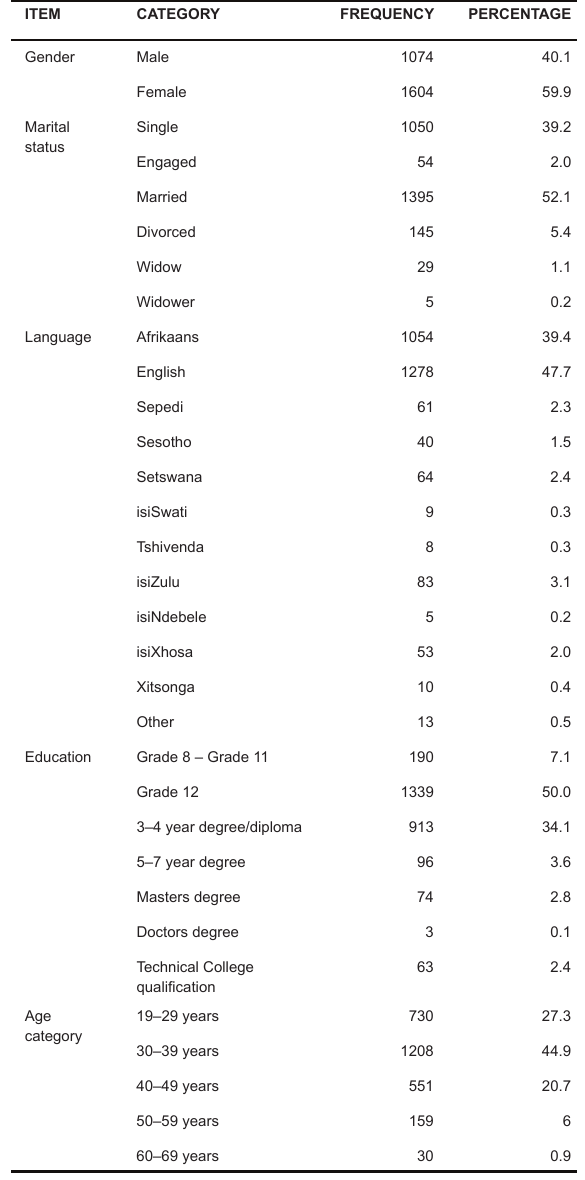
TABLE 1 Demographic characteristics of the